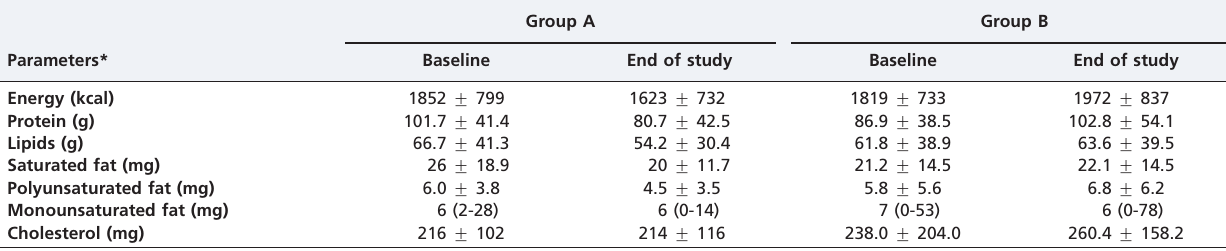
Table 2 - Food intake parameters of HIV-positive subjects with